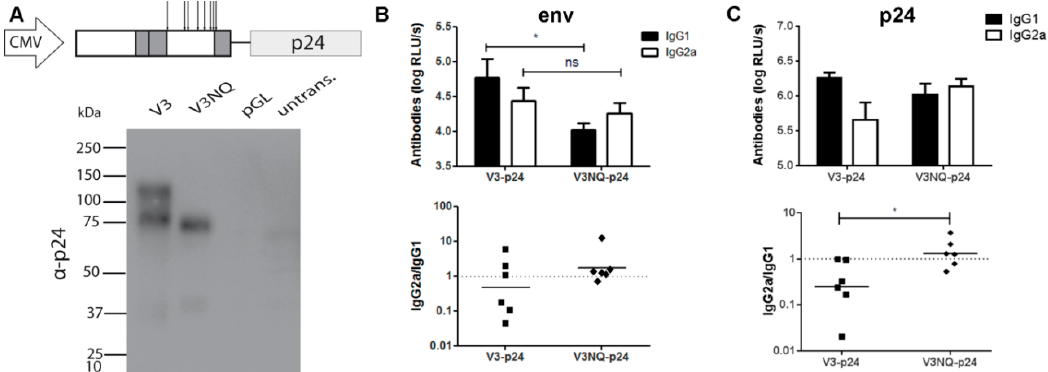
Figure 9. Impact of the glycosylation of the C2V3 region on the humoral immune response. ( A ) To delete all potential N-glycosylation sites from the C2V3 region, the Asn-coding triplets (indicated by arrows) in the construct V3-p24 were mutated to Gln-coding ones. 293T cells were transfected with the new construct, V3NQ, and deglycosylation of the Env variant was confirmed by Western Blot analyses of the supernatants with an p24-specific antibody. (V3 = glycosylated, V3NQ = not glycosylated, pGL = transfection control, untrans. = untransfected). Balb/c mice were immunized as described above with either V3-p24 or V3NQ-p24 and the antibody responses to Env ( B ) and p24 ( C ) were analyzed two weeks post boost immunization. The upper part shows the level of IgG1- and IgG2a-antibodies as mean values with SEM for six animals each (* p < 0.05, ns = not significant, Student’s t -test). The lower part depicts the ratio of IgG2a to IgG1 for each animal with bars indicating the geometrical mean values (* p < 0.05, ns = not significant,